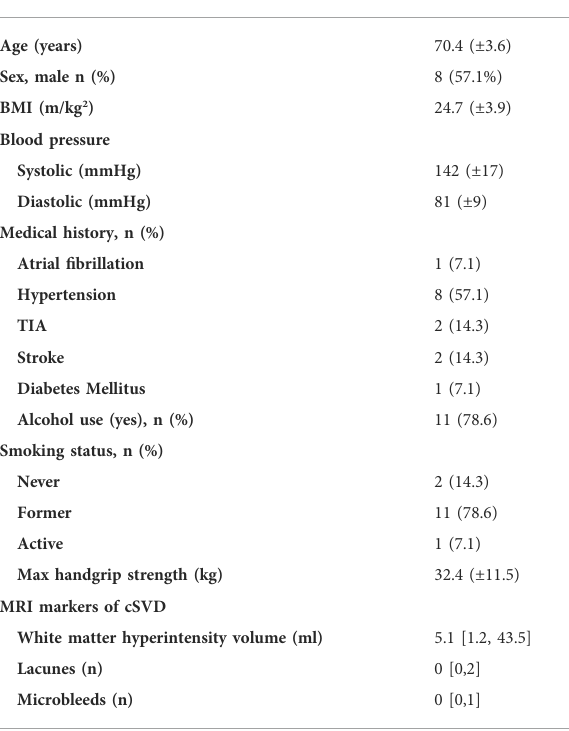
TABLE 1 Baseline characteristic. Table 1. Baseline